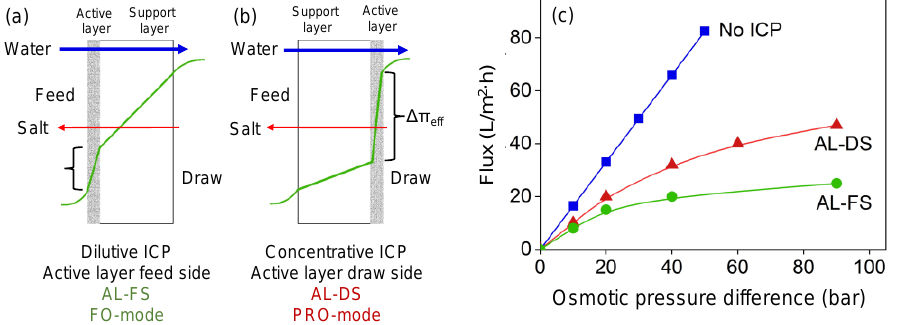
Figure 2. ( a ) Dilutive ICP; ( b ) Concentrative ICP; ( c ) impact of ICP on clean-water flux through the membrane.